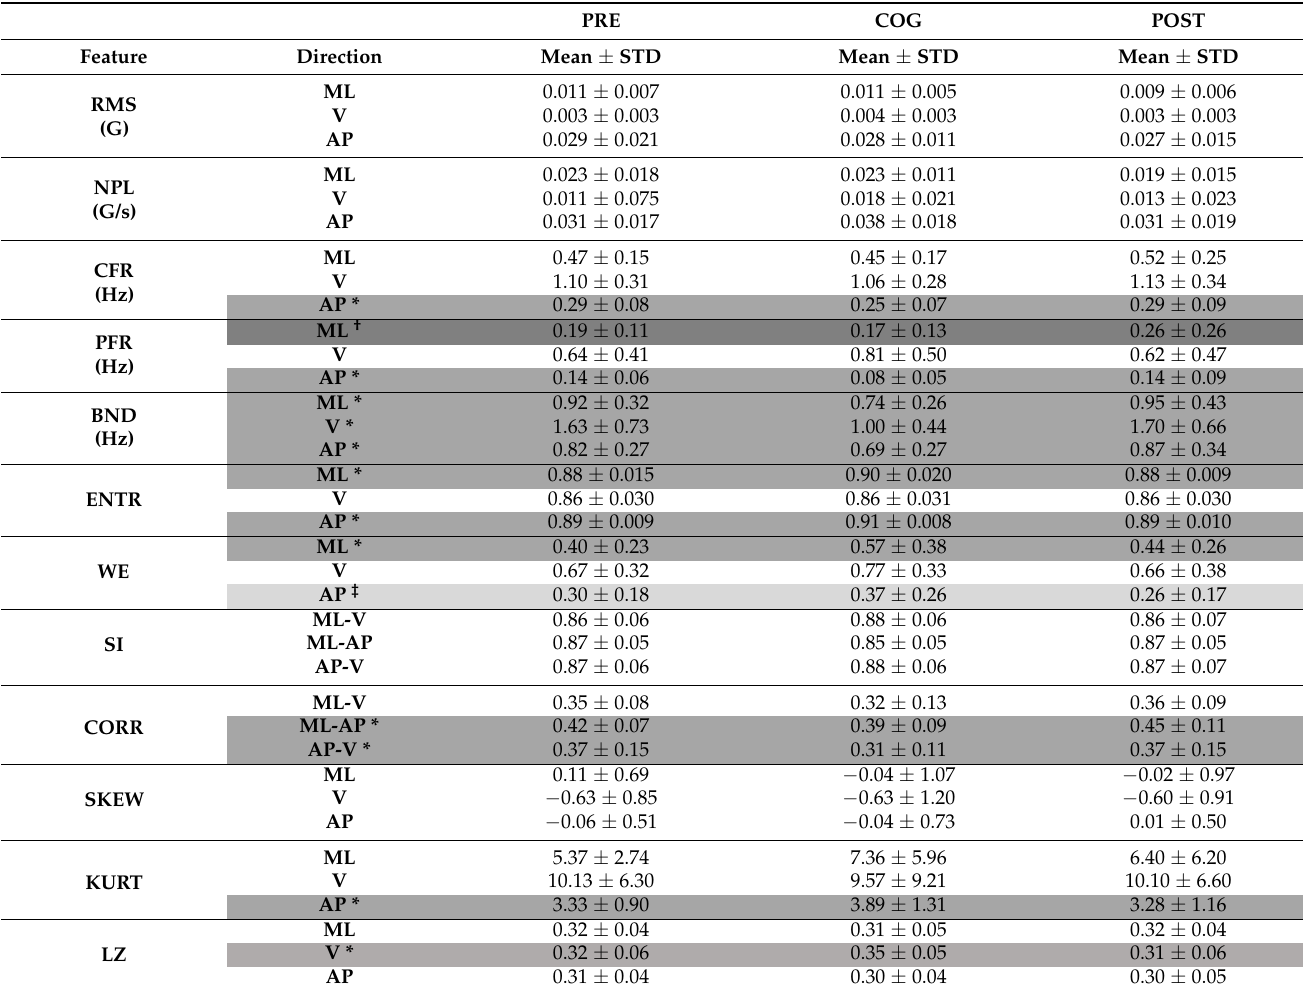
Table 2. Averaged raw values across task type for each feature in each direction. * (medium gray) Differences are significant between PRE and COG conditions; † (dark gray) Differences are significant between PRE and POST conditions; ‡ (light gray) PRE, COG, and POST are not all equal.